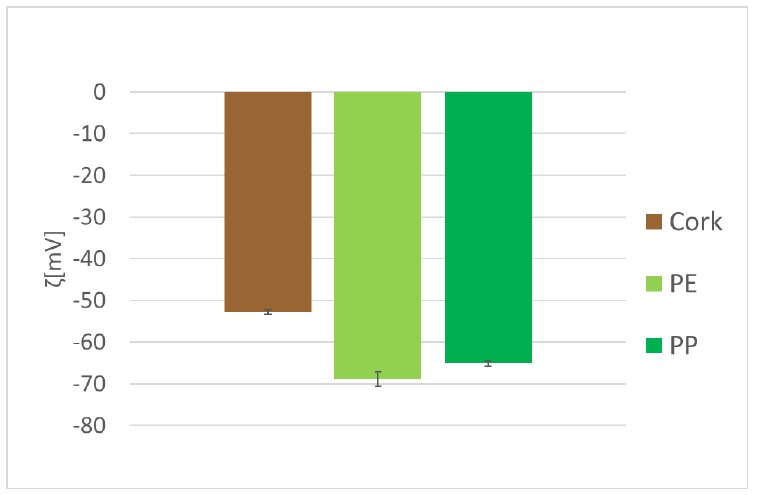
Figure 2. Field-emission scanning electron microscopy (FE-SEM) micrographs of cellular structure of foamed samples: ( a ) PEfoam, ( b ) Polyform, ( c ) Nora and ( d ) cork.